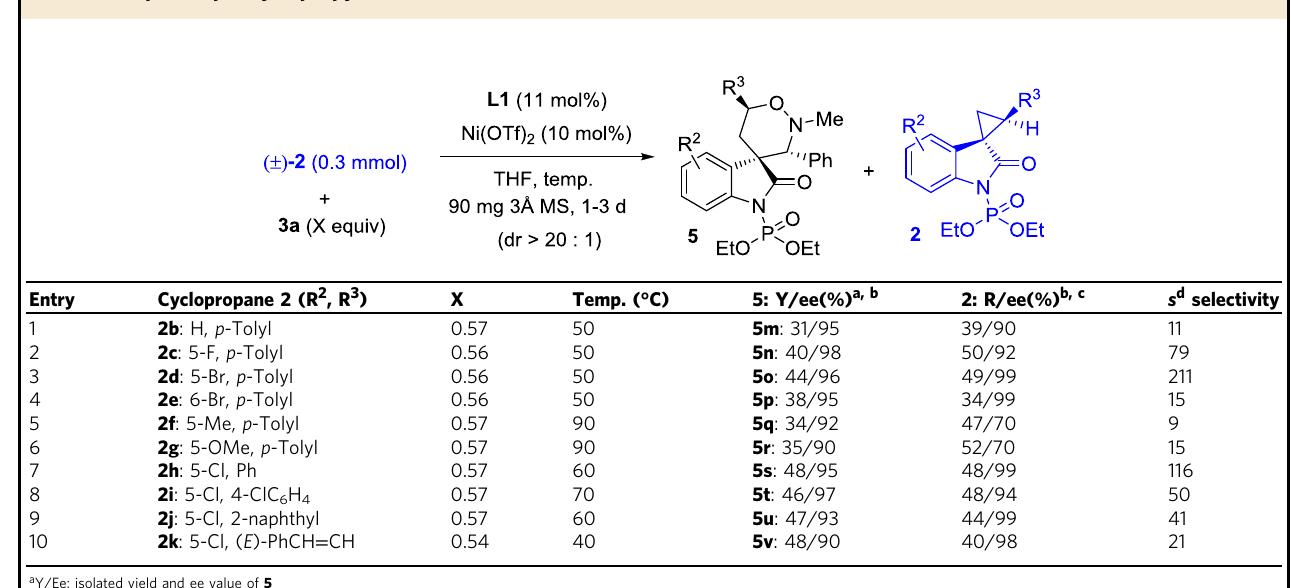
Table 4 Scope of spirocyclopropyl oxindoles